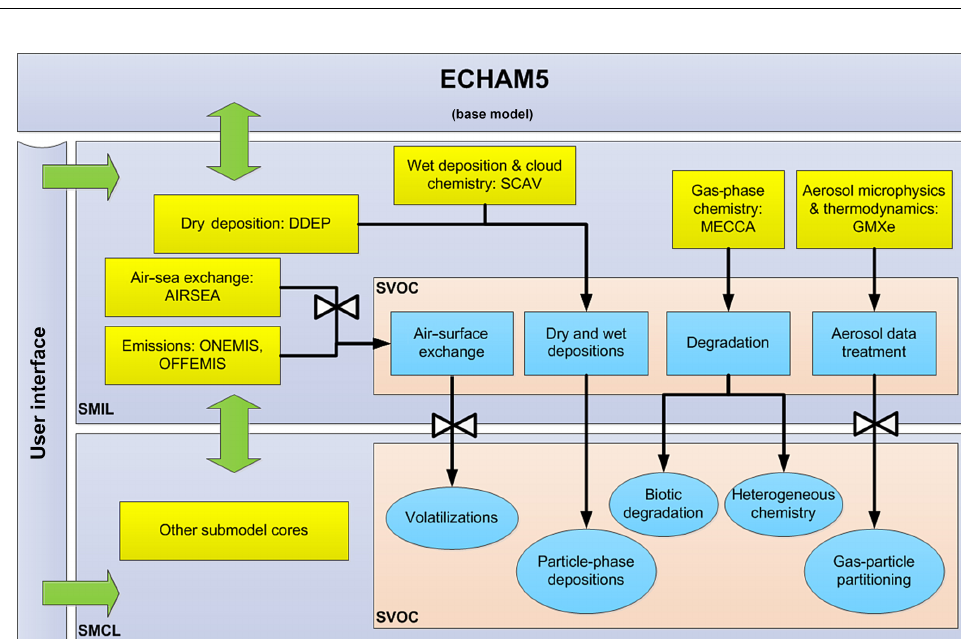
Figure 1. Overview of EMAC-SVOC model structure, the cycling processes in SVOC submodel, and its interaction with other MESSy submodels. SMIL (submodel interface layer) and SMCL (submodel core layer) are components of MESSy coding standard, see Jöckel et al. (2006) for further